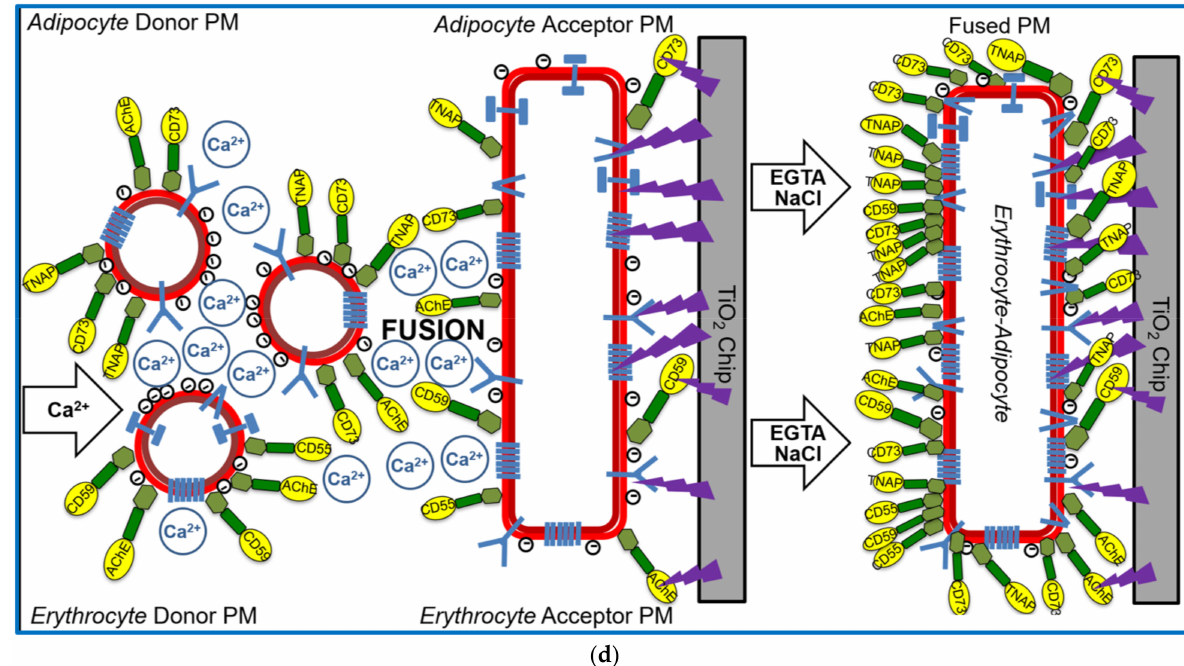
Figure 1. Model of the cell-free chip-based sensing system for analysis of transfer of GPI-APs between adipocyte and erythrocyte PM and the effect of serum proteins. ( a ) Ionic (middle panel) and covalent (right panel) capture of acceptor adipocyte and erythrocyte PM with legend for symbols (left panel). The possibility of formation of extended flat vesicular structures of PM at the chip surface in course of covalent capture is indicated. ( b , c ) Injection of adipocyte and erythrocyte donor PM together with EGTA in the absence ( b ) or presence ( c ) of serum proteins for analysis of transfer of GPI-APs to covalently captured adipocyte and erythrocyte acceptor PM via micelle-like GPI-AP complexes resulting in acceptor PM with transferred GPI-APs in the absence ( b ), but not in the presence ( c ), of serum proteins. The two combinations of donor and acceptor PM exhibiting the highest and lowest transfer efficacy for GPI-APs in the absence of serum proteins ( b ), hE → rE/hA (lower half) and h/rA → h/ rE (upper half), respectively, are depicted (see also Table 1). ( d ) Injection of adipocyte and erythrocyte donor PM together with Ca 2+ (left panel) for analysis of the fusion of adipocyte and erythrocyte donor and acceptor PM (middle panel). In all cases the TiO 2 chips were sensed for GPI-APs and transmembrane proteins and the corresponding antibodies loaded onto the chip by measurement of SAW phase